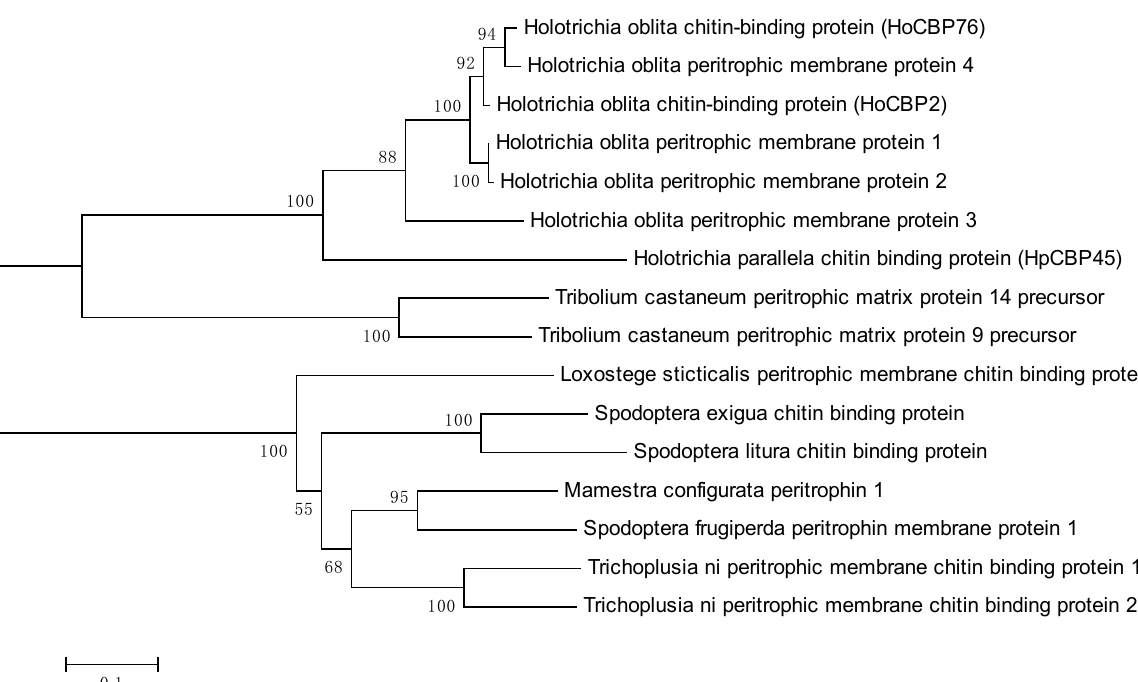
Figure 3. Phylogenetic tree based on amino acid sequence of HpCBP45 and other PM